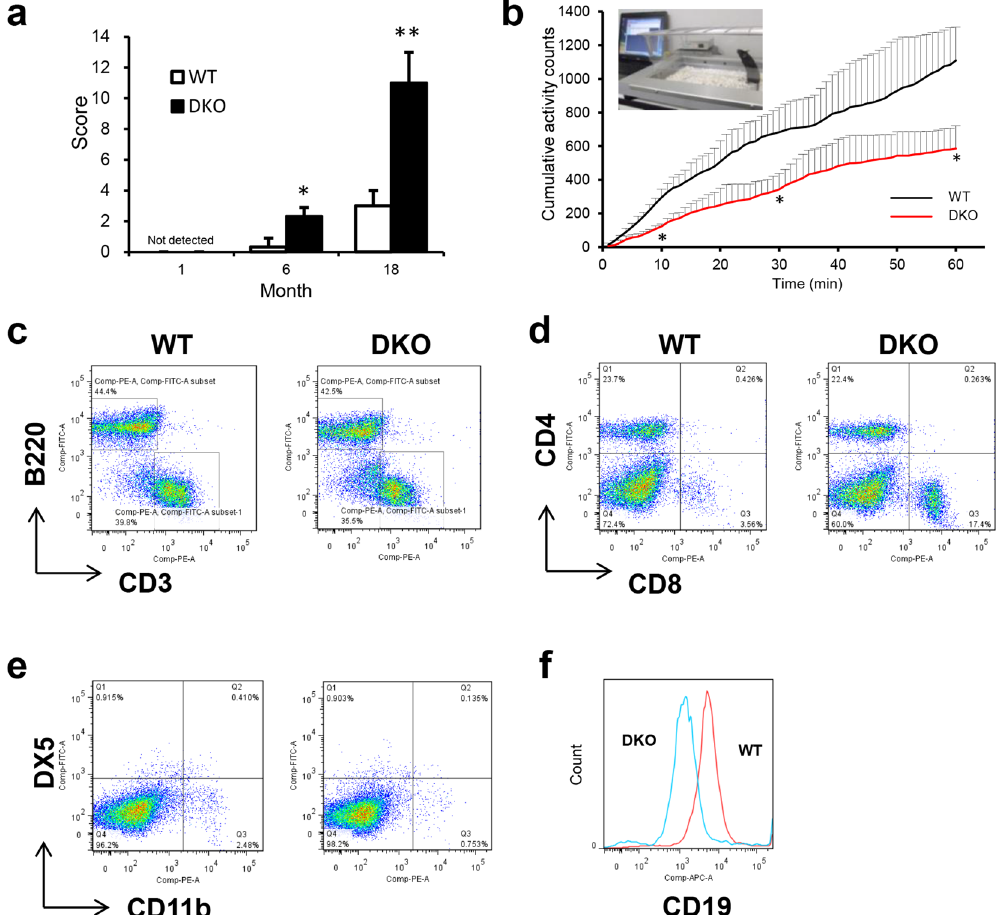
mice at 70 weeks of age. B220: B cells, Thy1.2: T cells, CD4 and CD8: T helper cell subset, CD11b: neutrophils, DX5: NK cells, CD19: B cell subset. Bars represent means ± SD; * P < 0.05, ** P < 0.01 versus